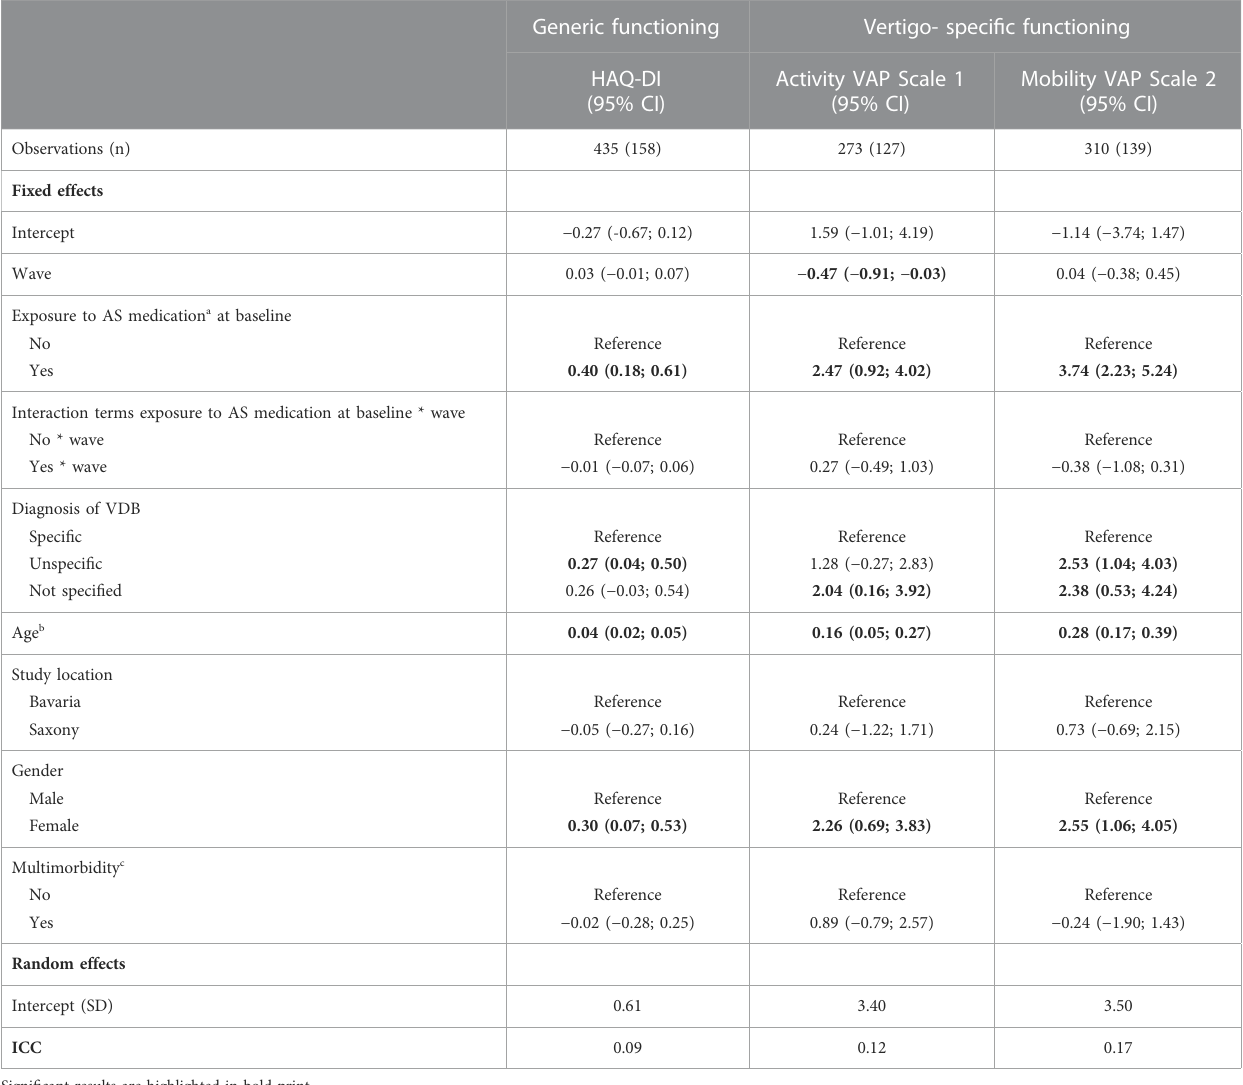
TABLE 2 Longitudinal linear mixed models to assess the in fl uence of exposure to AS medication on generic functioning (HAQ-DI) and vertigo-speci fi c functioning (Activity VAP Scale one and Mobility VAP Scale